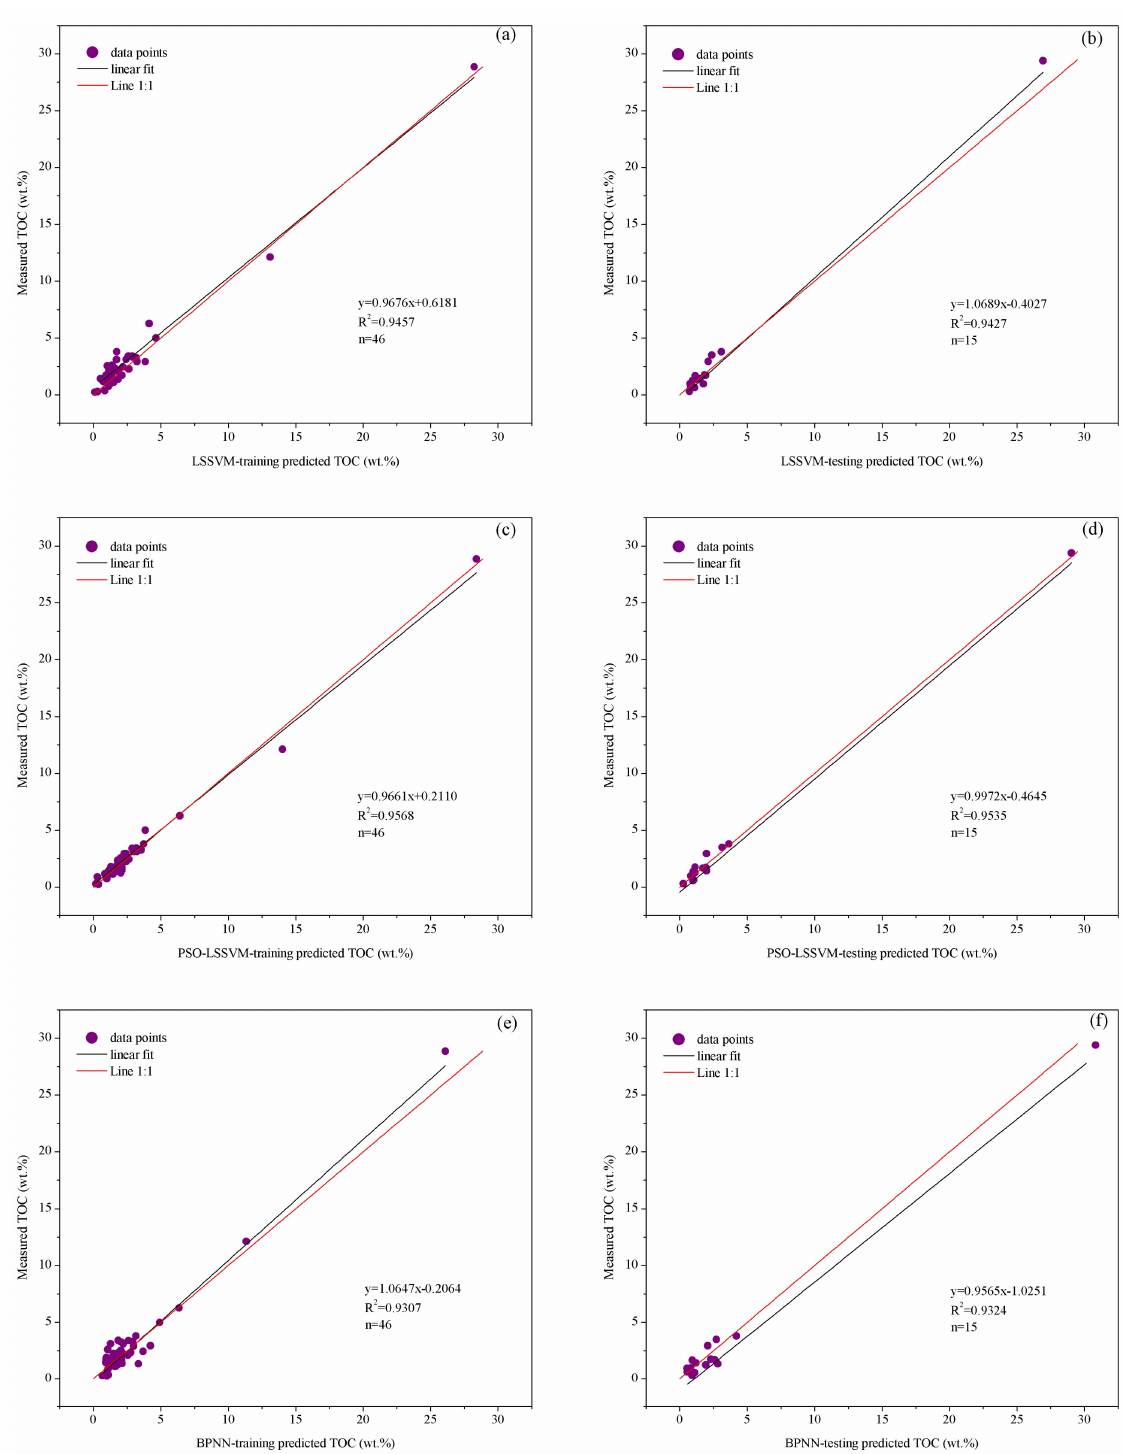
Figure 8. Comparison of the TOC prediction results with the optimization samples data and laboratory measured TOC: ( a ) LSSVM-training results; ( b ) LSSVM-testing results; ( c ) PSO-LSSVM-training results; ( d ) PSO-LSSVM-testing results; ( e ) BPNN-training results; and ( f ) BPNN-testing